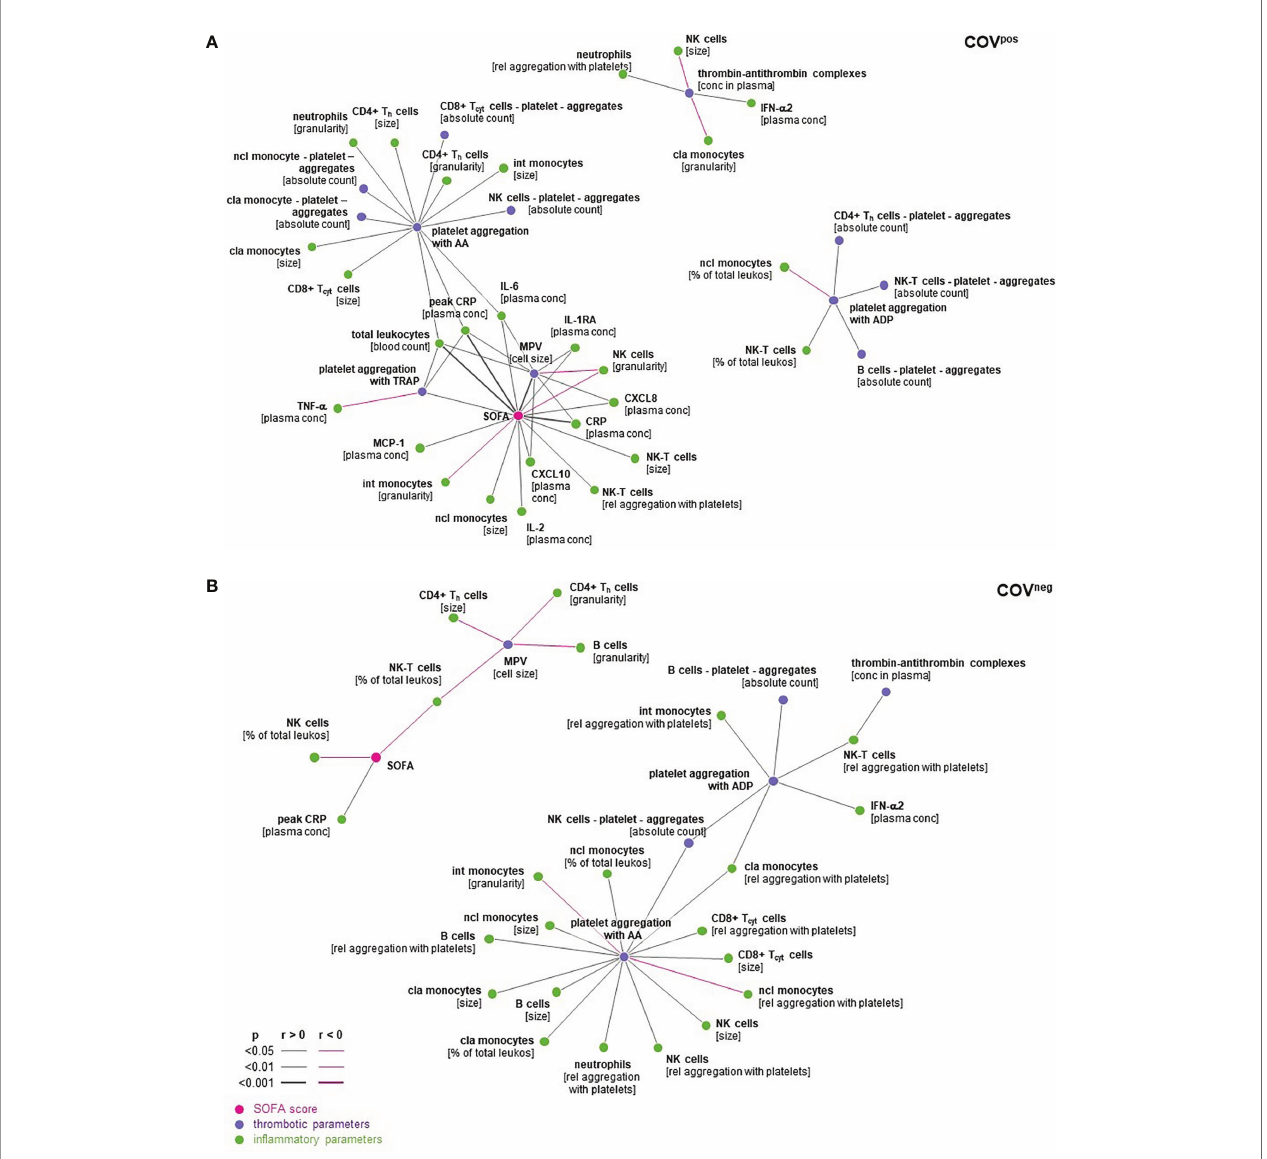
FIGURE 5 | Spearman ’ s correlations in COV pos (A) and COV neg (B) were expressed as dark grey lines if positively correlated and pink lines if correlated inversely. Correlations with p < 0.05 are depicted. cla Mo, classical monocytes; int Mo, intermediate monocytes; ncl Mo, nonclassical monocytes; T h , CD4 pos helper T cells; T cyt , CD8 pos cytoxic T cells; NK-T, natural killer T cells; NK cells, natural killer cells; peak CRP, highest CPR level during hospital